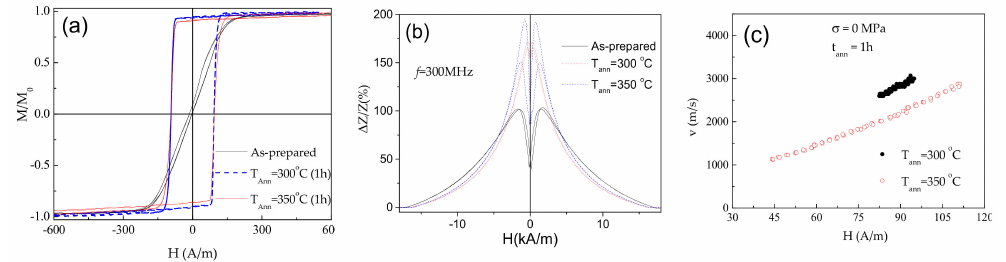
Figure 3. E ff ect of annealing on hysteresis loops ( a ), ∆ Z / Z(H) dependencies measured at 300 MHz ( b ) and on v (H) dependencies ( c ) of annealed at T ann = 300 ◦ C and 350 ◦ C Co 69.2 Fe 3.6 Ni 1 B 12.5 Si 11 C 1.2 Mo 1.5 microwires.